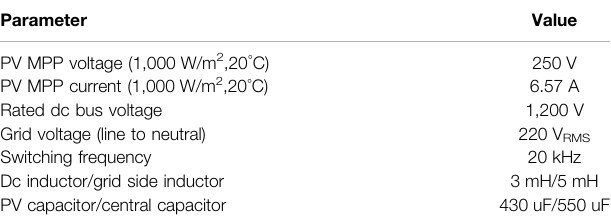
TABLE 6 | Parameters of the simulation model. Parameter